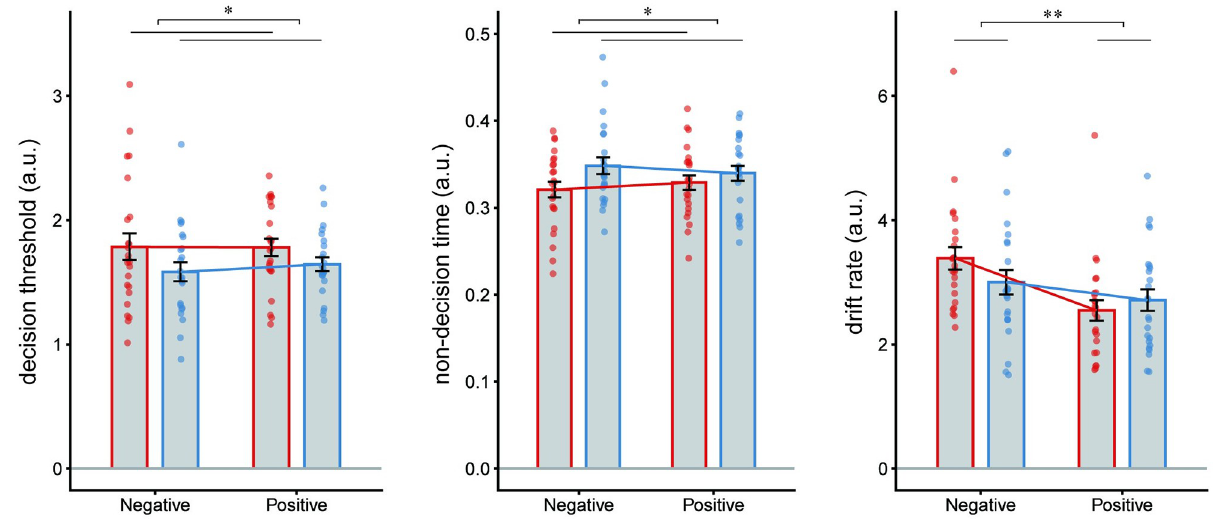
Fig 4. The ANOVA results estimated DDM parameters decision threshold (left panel), non-decision time (center panel), and drift rate (right panel). The results show a significant main effect of group in decision threshold and non-decision time, and a significant main effect of condition in drift rate. Nonsmokers’ data is shown in orange and smokers’ in blue. Error bars indicates standard error. � p < .05, �� p < .01.